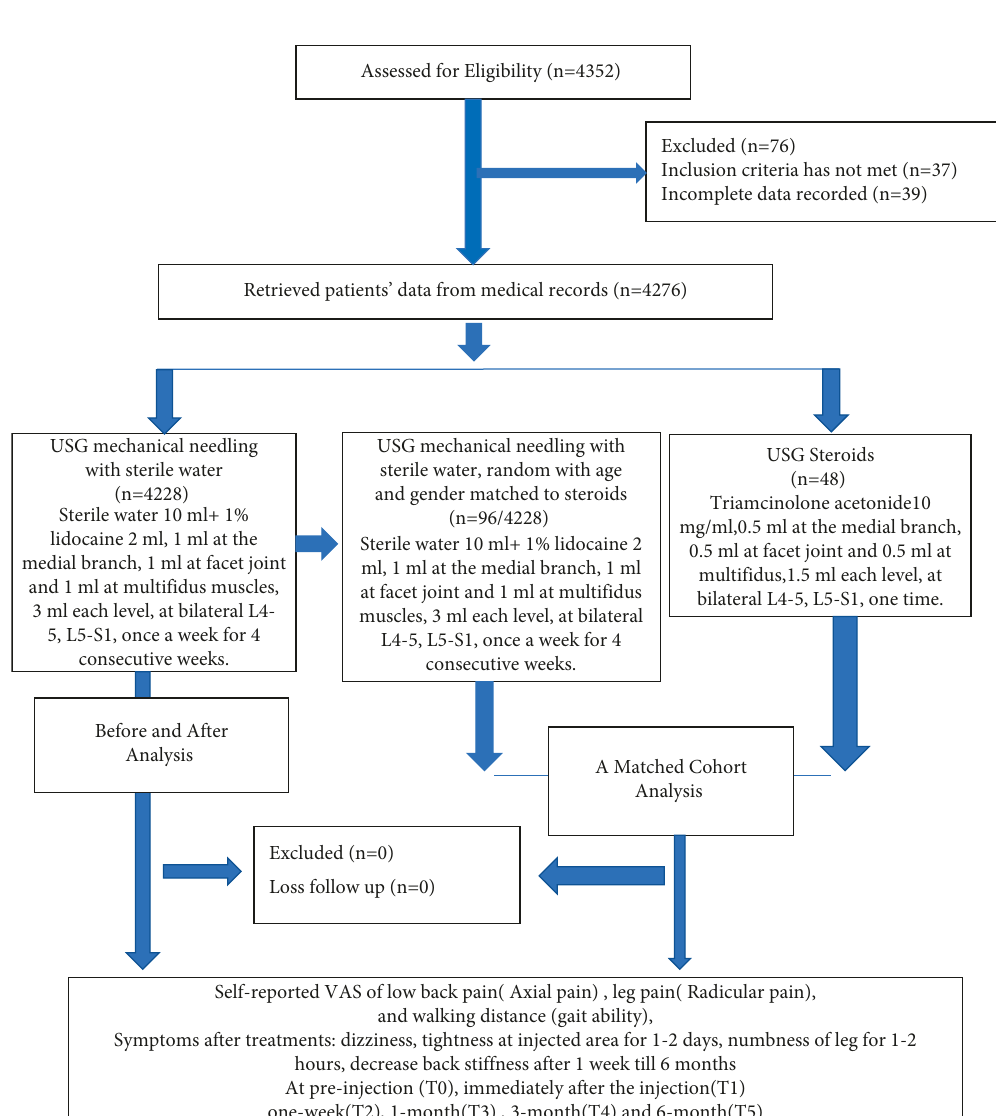
Figure 1: STROBE